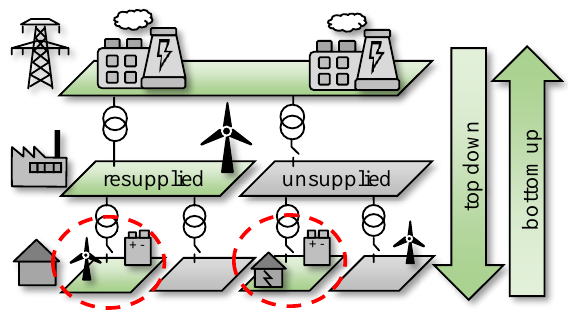
Fig. 1. System restoration process: top down & bottom